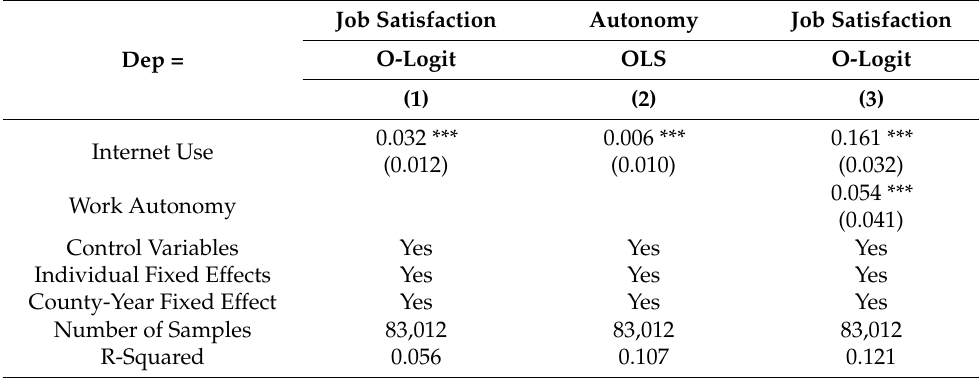
Table 11. Internet Use, Job Autonomy and Job